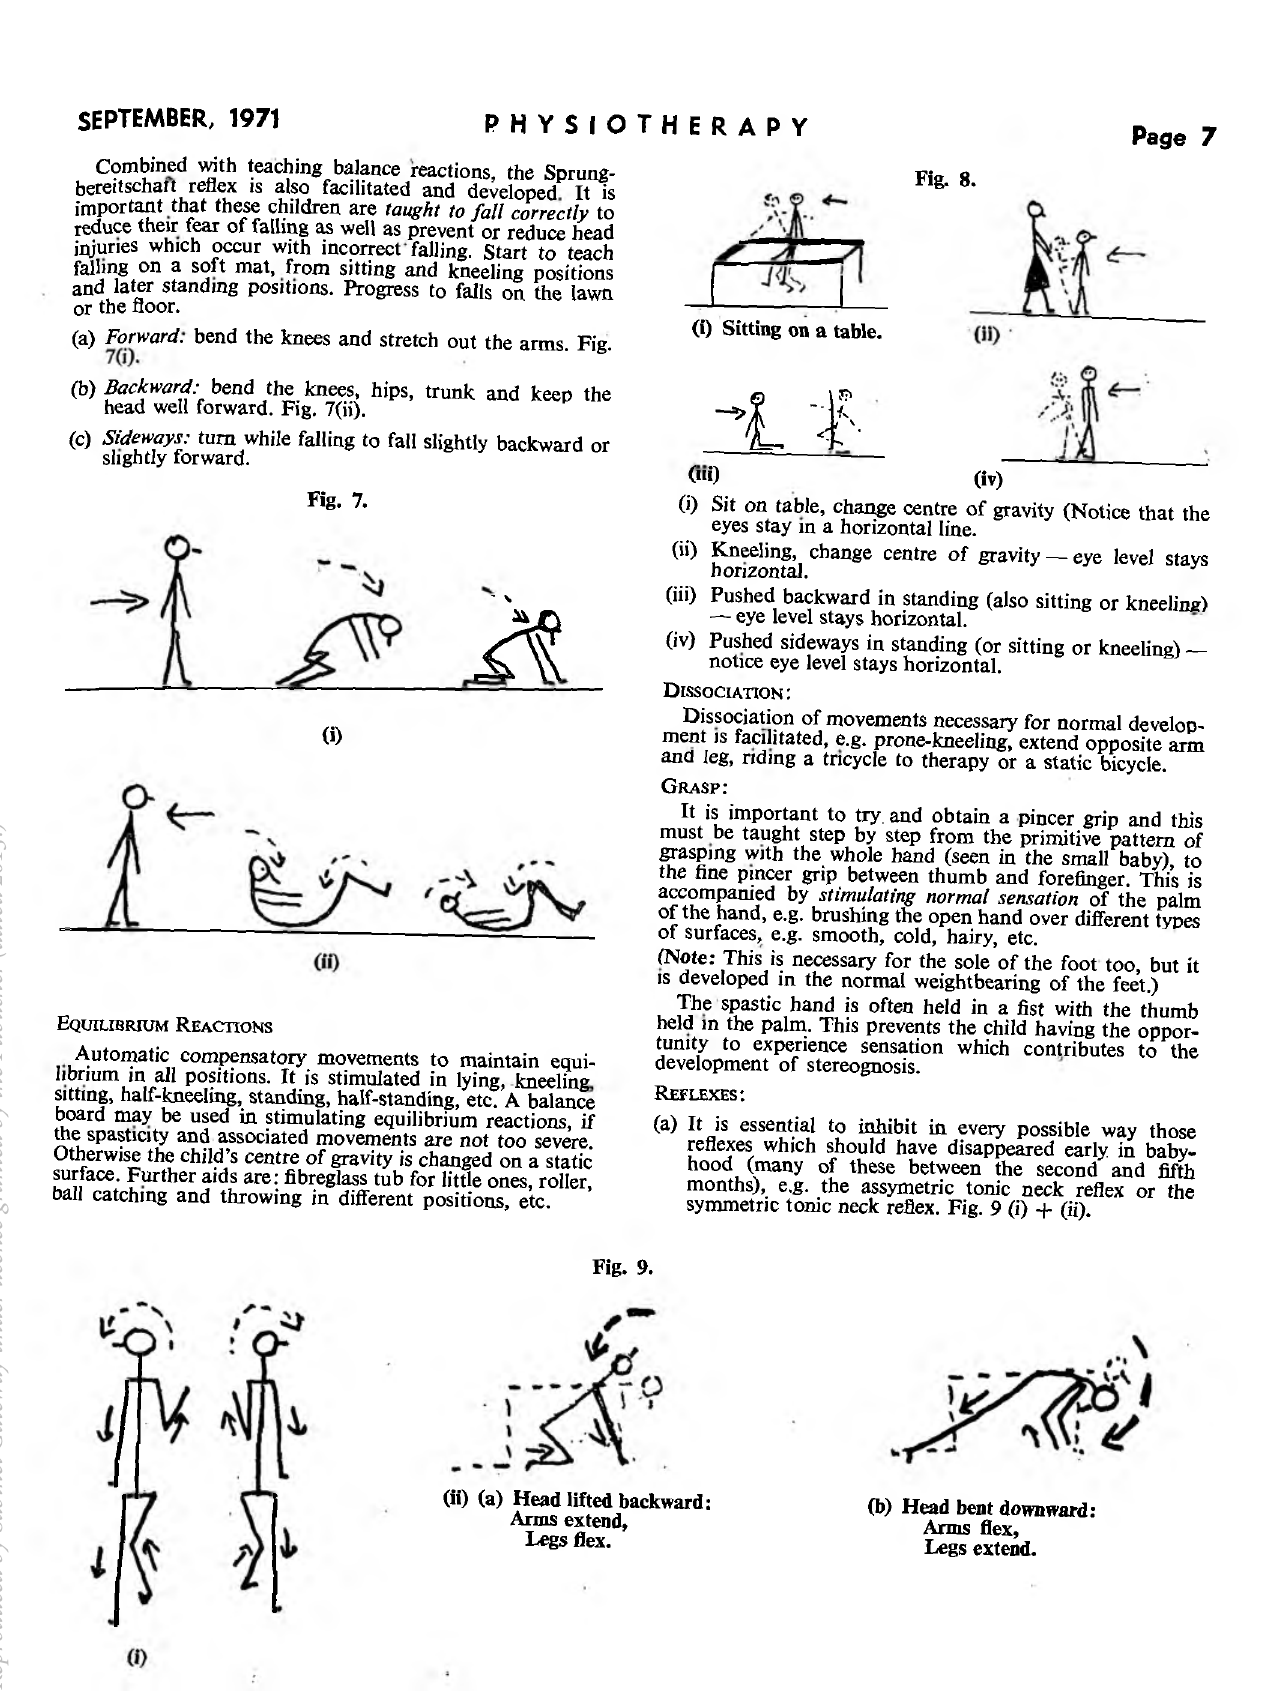
(b) Head bent downward: Arms